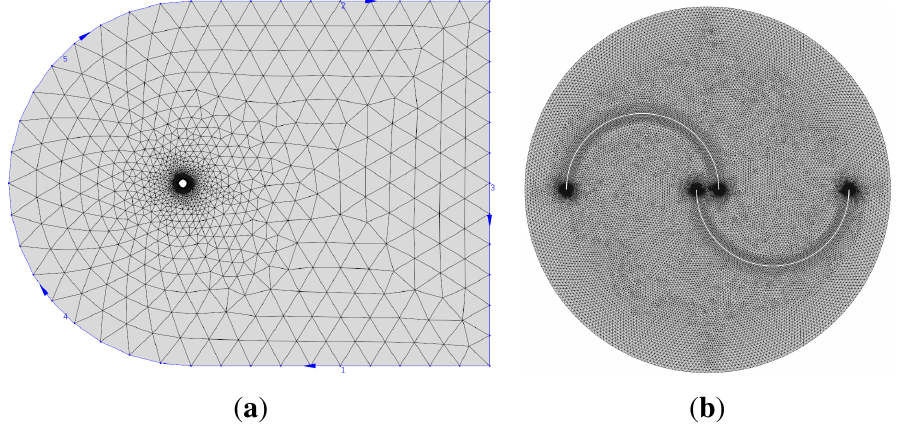
Figure 3. Mesh characteristics of the ( a ) fixed domain; and ( b ) rotating